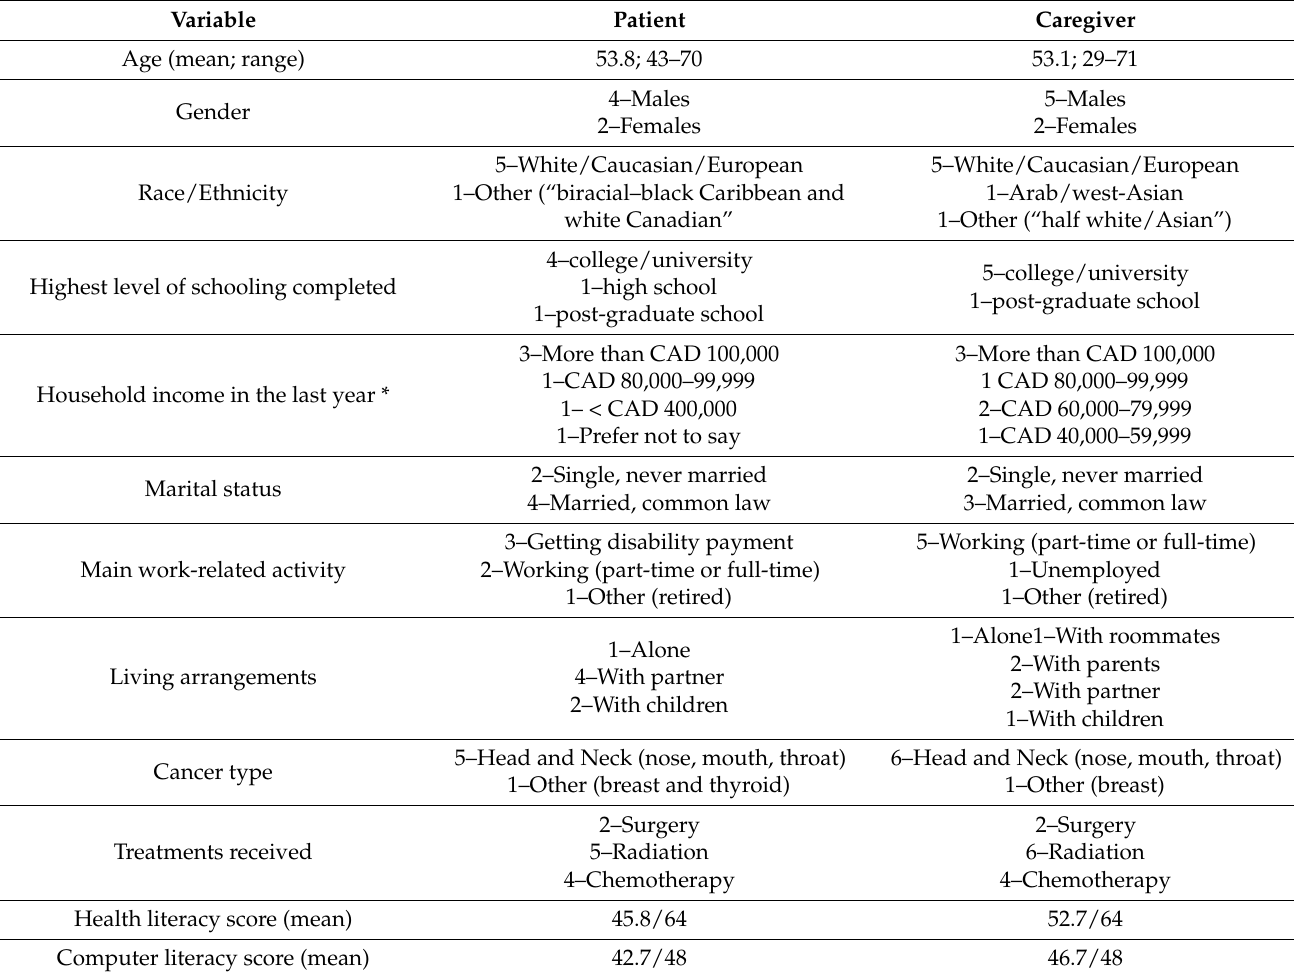
Table 1. Participant demographic characteristics. Health literacy score; computer literacy